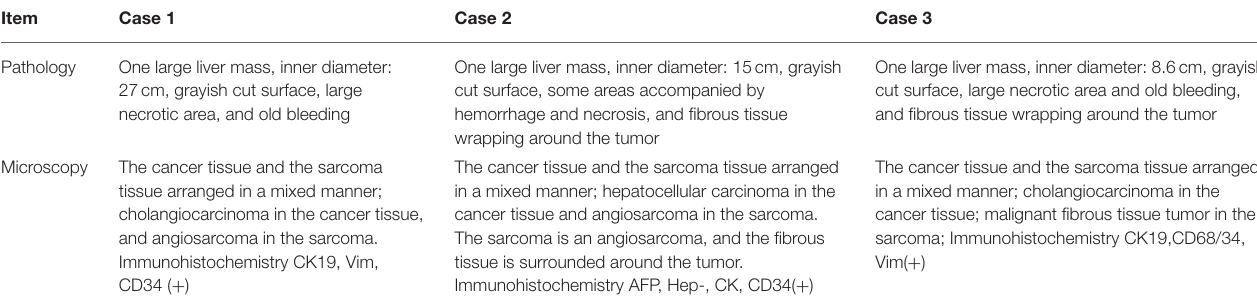
TABLE 2 | Pathological features of three cases with